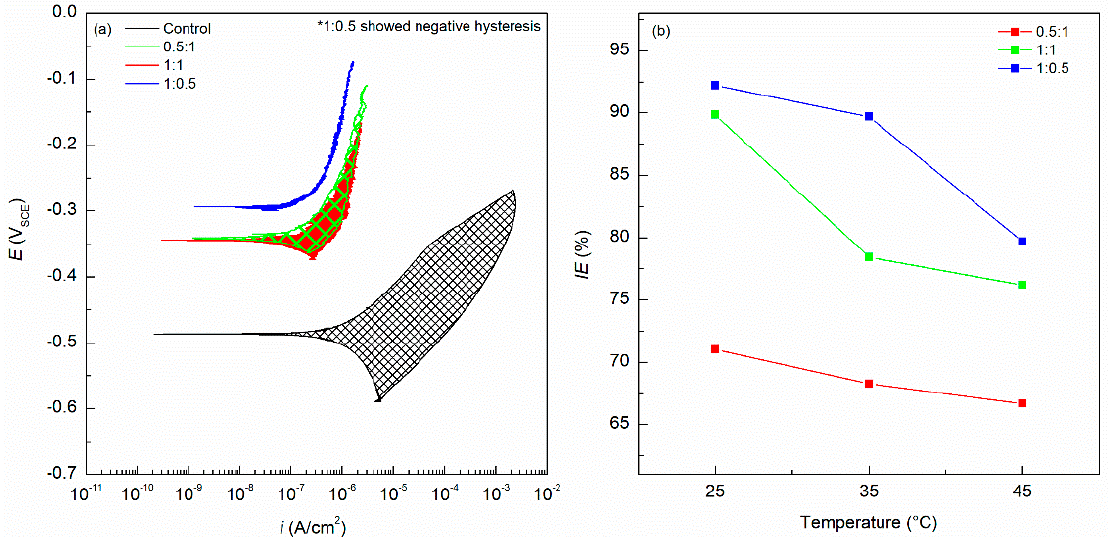
Figure 4. The representation of ( a ) the anodic areas of the CPP curves at 25 °C in SCPS with 0.6 M NaCl, and ( b ) the IE obtained from SCPS with 0.6M NaCl at 25, 35, and 45 °C. The IE graph is plotted against temperature for each inhibitor ratio in Figure 4b.